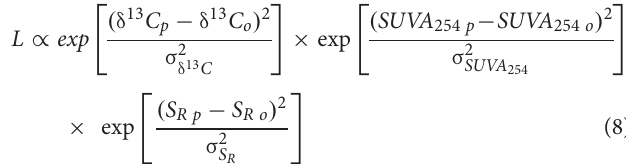
Supplementary Figure S2B ); NRE values were larger than all of the river samples throughout the period